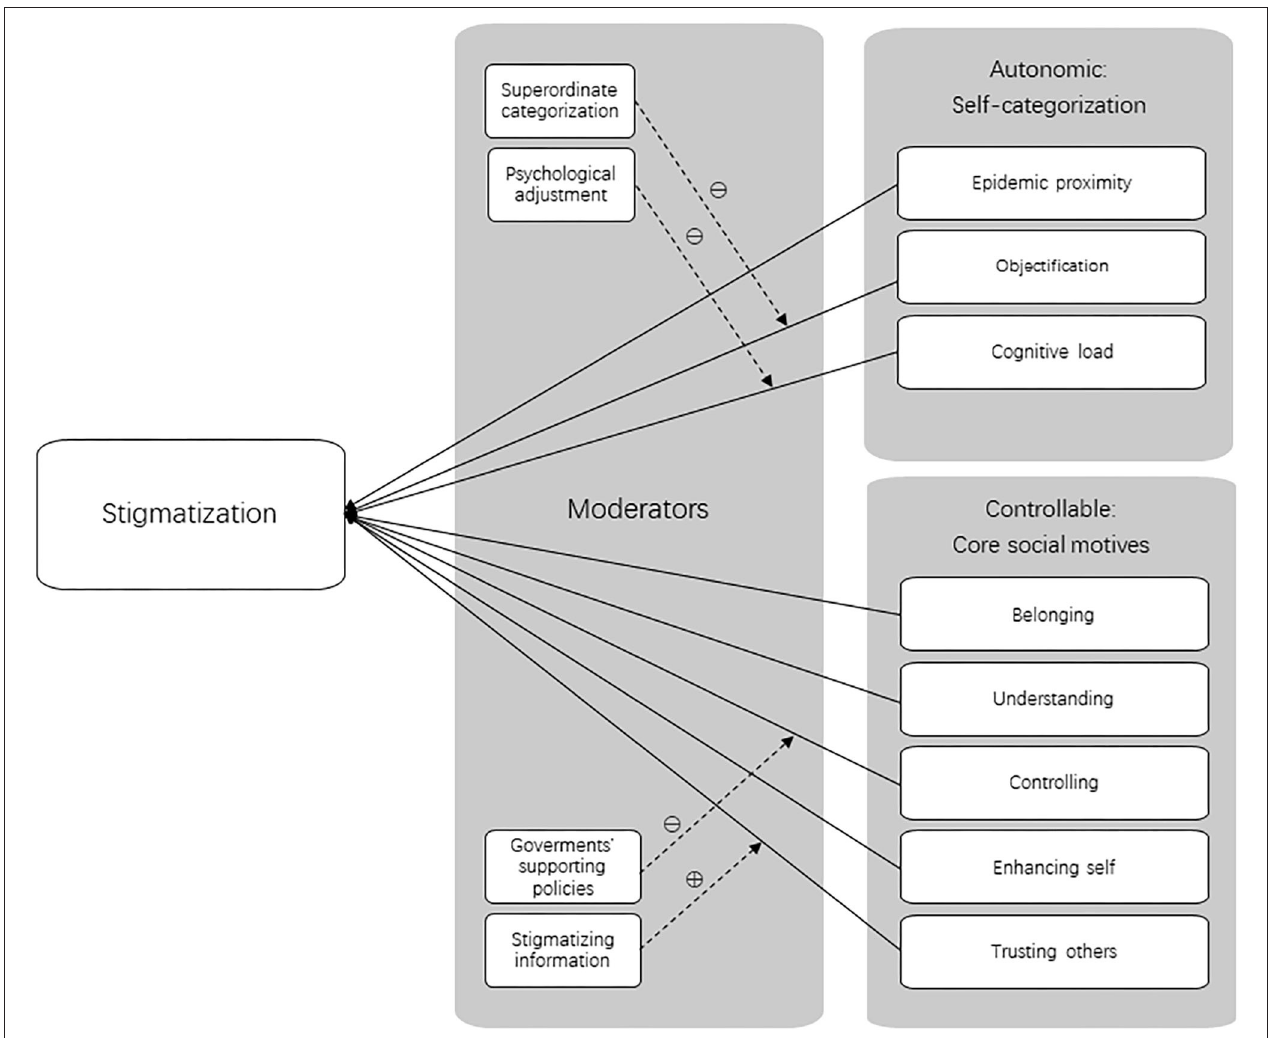
FIGURE 1 | Theoretical models. Components in self-categorization theory and core social motives (BUC[K]ET) and proposed moderators.